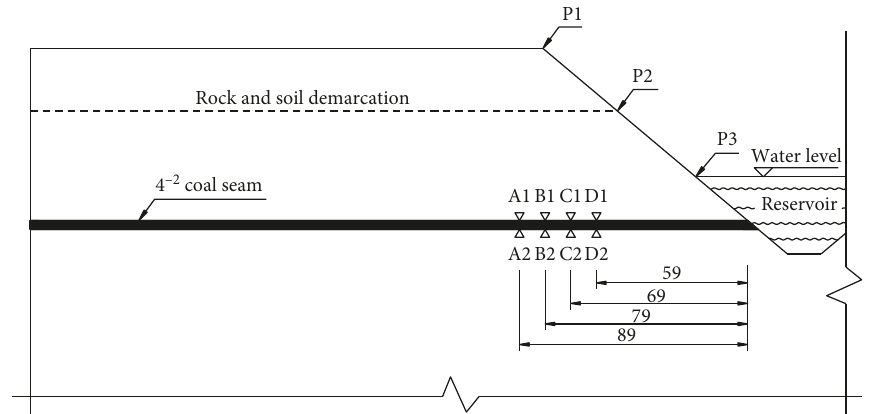
Figure 7: Layout of the monitoring points in the numerical simulation